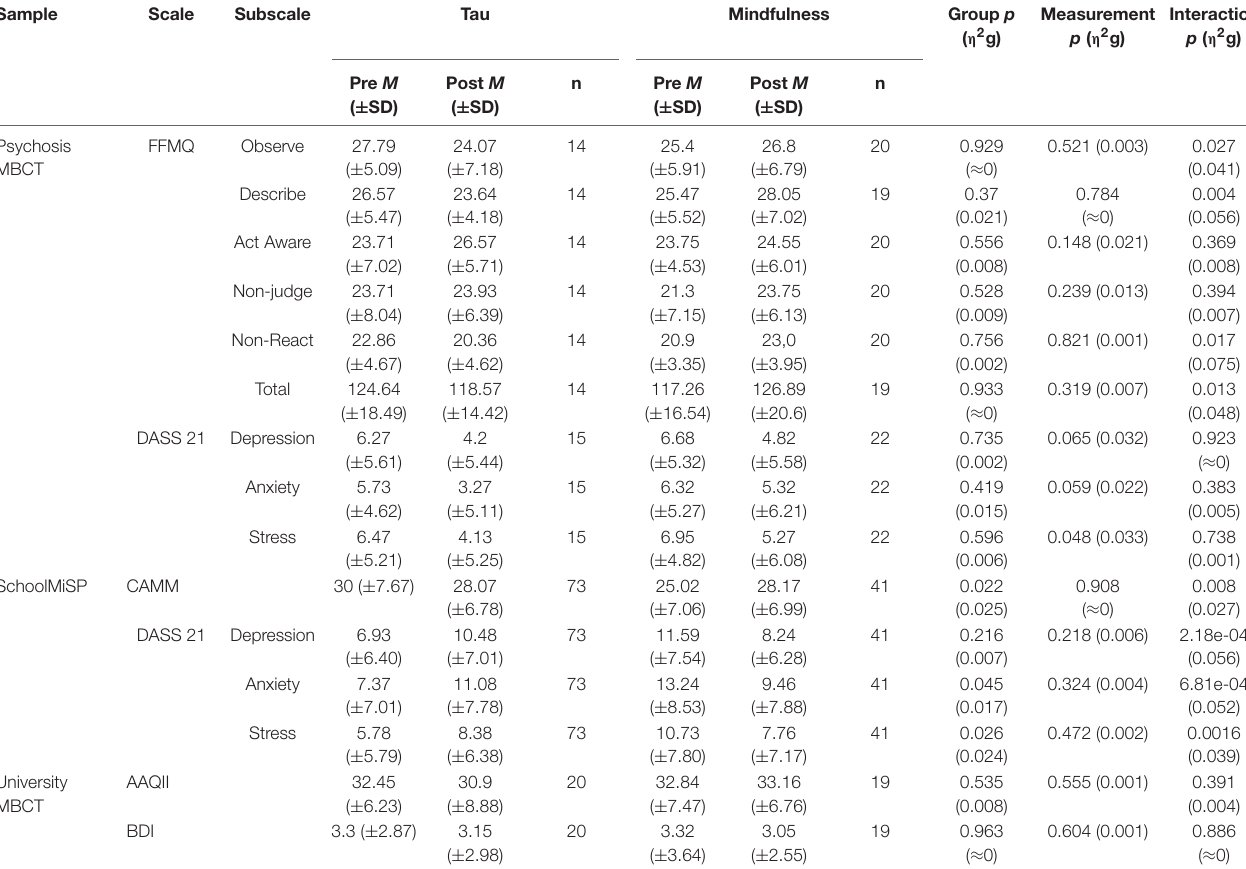
TABLE 2 | Mixed ANOVA results for the three RCTs.